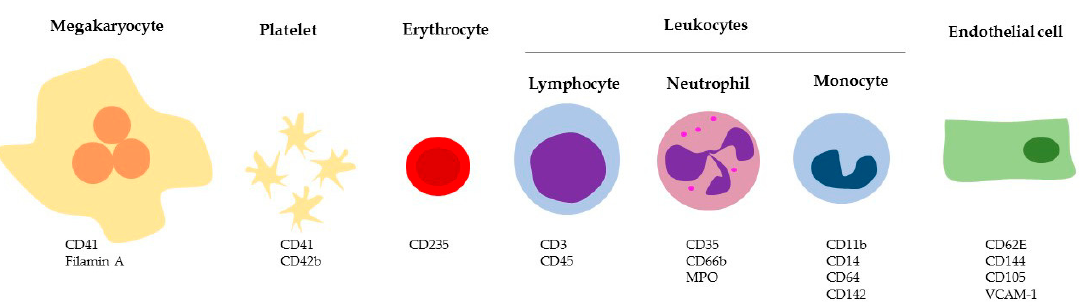
Figure 2. Specific cellular markers of EVs. MPO: myeloperoxidase; VCAM-1 Vascular cell adhesion protein 1.